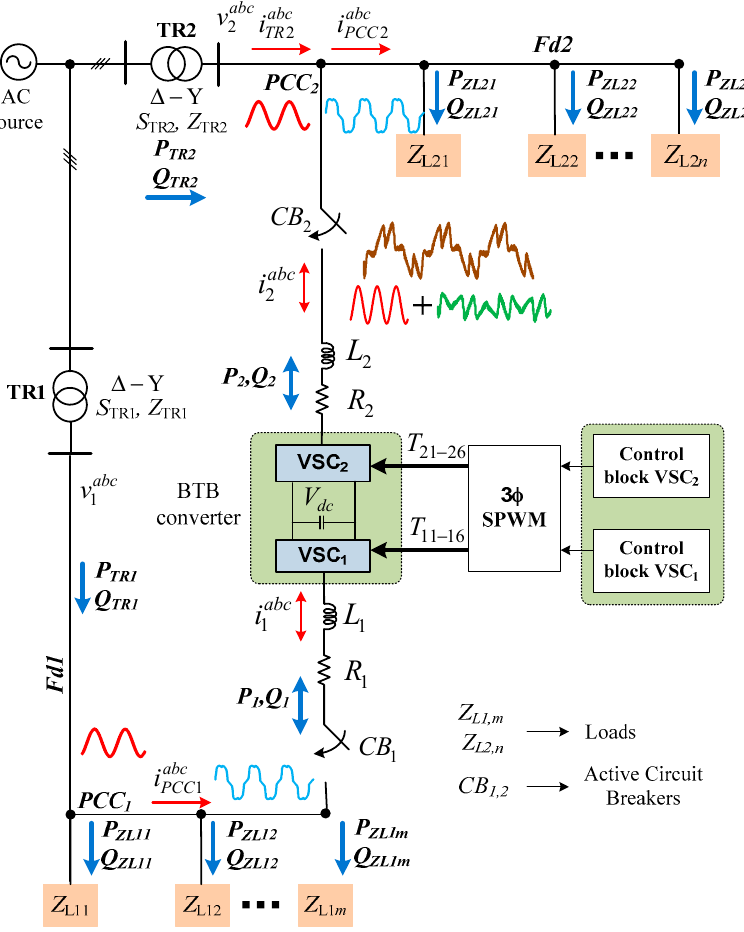
Figure 1. Simplified configuration of the proposed system.